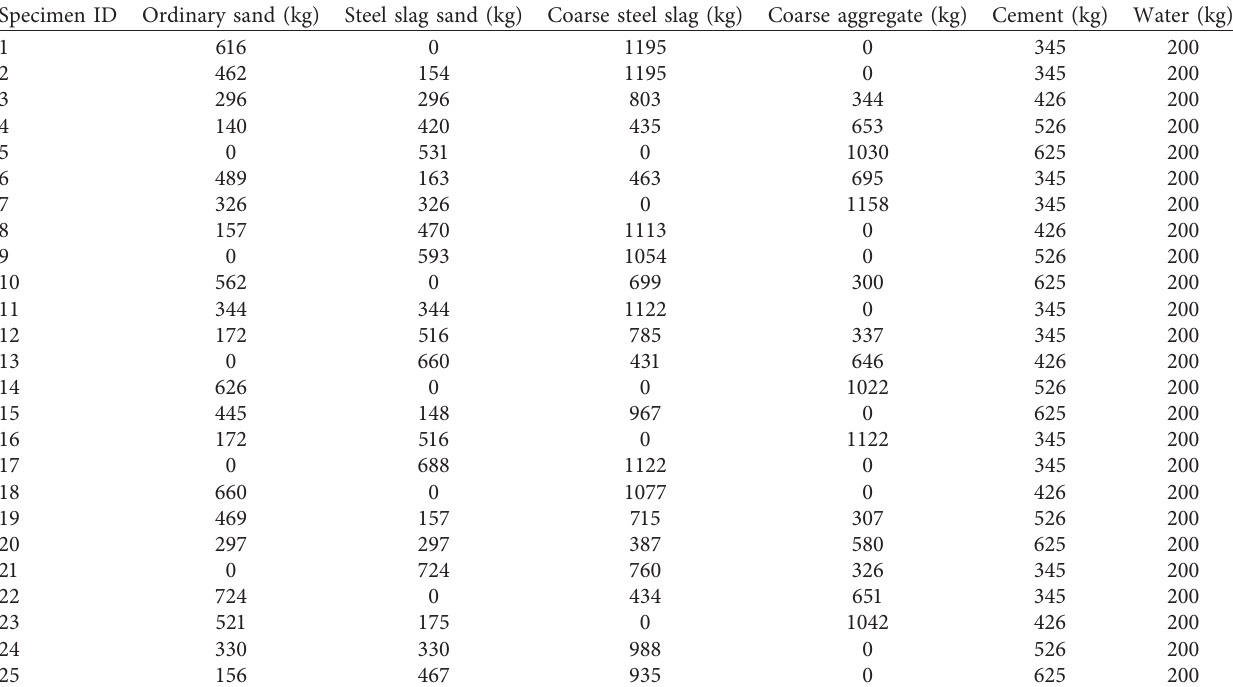
Table 4: Amount of various materials of the FSSAC (kg/m 3 ).